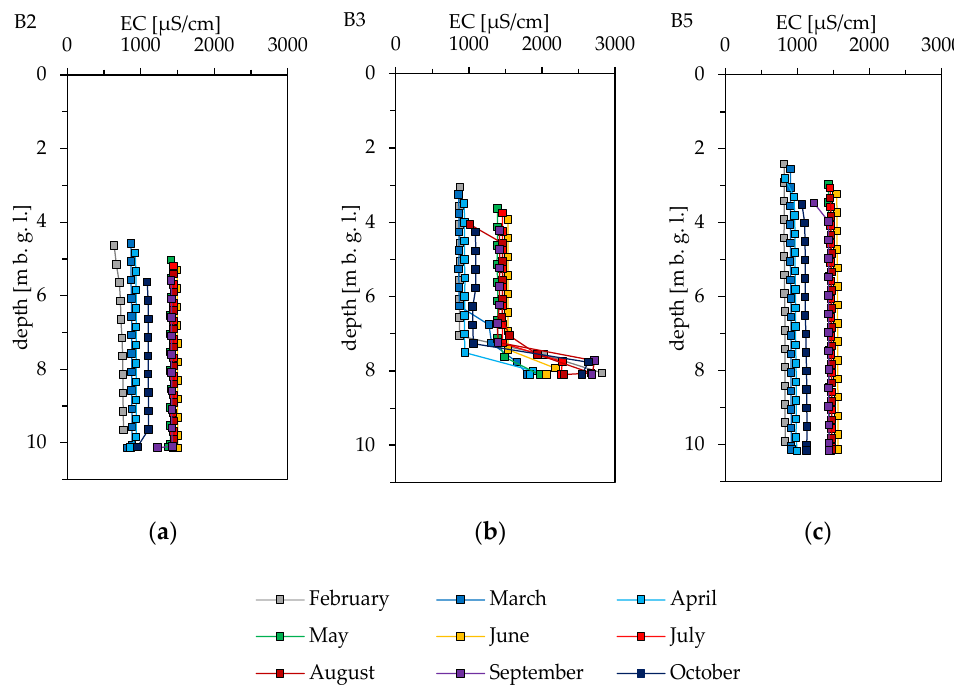
Figure 4. Measured electrical conductivities (EC) of groundwater in selected boreholes; ( a ) B2; ( b ) B3; ( c ); B5.